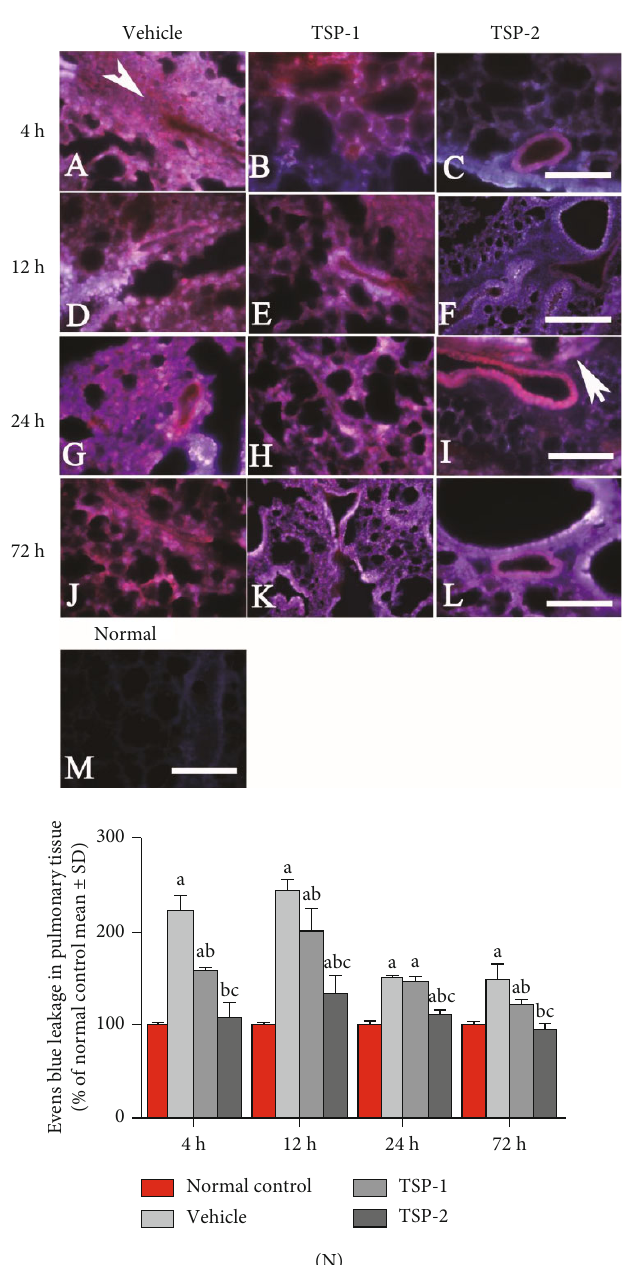
Figure 5: The impact of TSP-2 on pulmonary vascular permeability in the ARDS mouse model. (a – l) Evans blue (EB) staining is shown as an index of pulmonary vascular permeability in lung sections collected from vehicle, TSP-1, and TSP-2-overexpressing mice. (m) Normal mice. (n) Percentage of EB leakage in pulmonary tissue compared to normal control. EB staining was visualized using red laser excitation at 405 nm OD. Blue color represents no EB leakage into the pulmonary tissue, red color depicts high EB leakage due to enhanced vascular permeability, and pink color shows medium vascular permeability. The arrows point to the site of EB leakage. Scale bar = 100 μ m and n = 5 . (n) Evans blue leakage in pulmonary tissue ( μ g/g) is shown as mean ± SD . P value of < 0.05 represents signi fi cant di ff erence. a P < 0 : 05 compared with normal control; b P < 0 : 05 compared with the vehicle group; c P < 0 : 05 compared with the TSP-1 transfected group ( n = 4 per